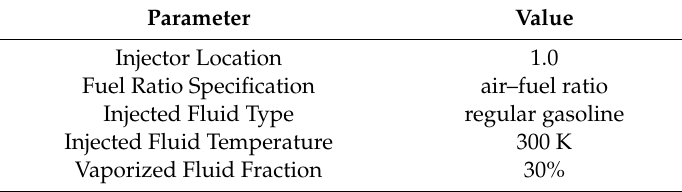
Table 7. Parameter settings of the simulation module of fuel injection system.